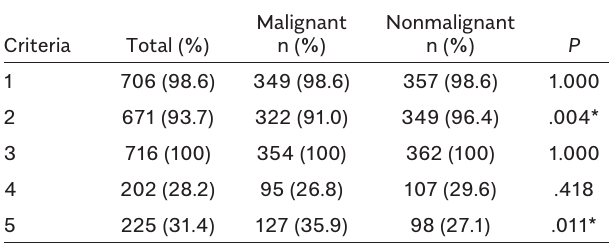
Table 5. Radiological Diagnostic Criteria in Patients with Mesenteric Panniculitis